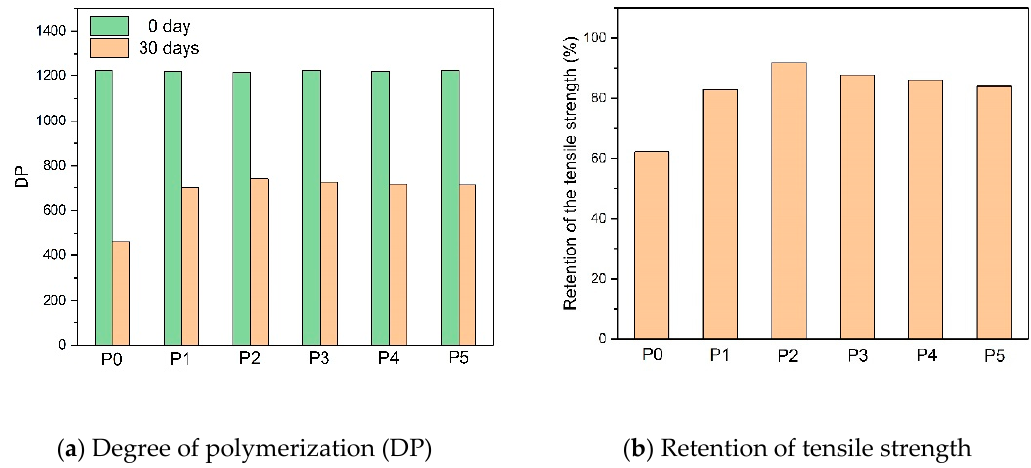
Figure 3. The influence of the different amine compounds on the thermal stability of paper.